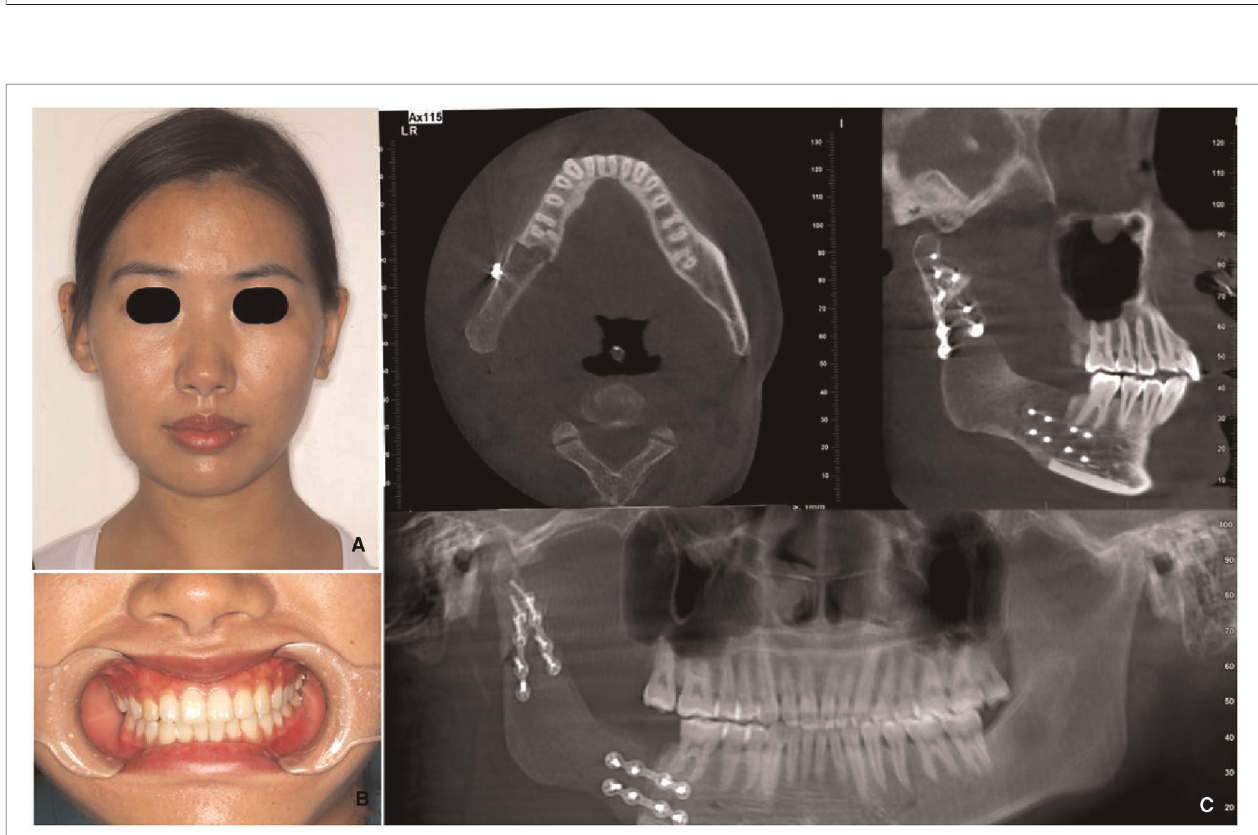
FIGURE 5 | Postoperative anterior view showing that the mandible is symmetrical for 3 months after operation ( A ); postoperative CBCT demonstrating that both the shape of the mandible and the height and width of the alveolar crest are satisfactory ( B ). L stands for the left side, R stands for the right side, both sides are ruler.